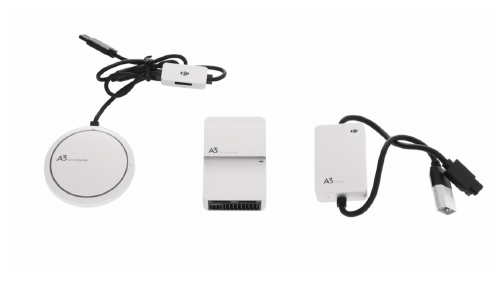
Figure 3. Appearance of A3 as a UAV control device using GPS.